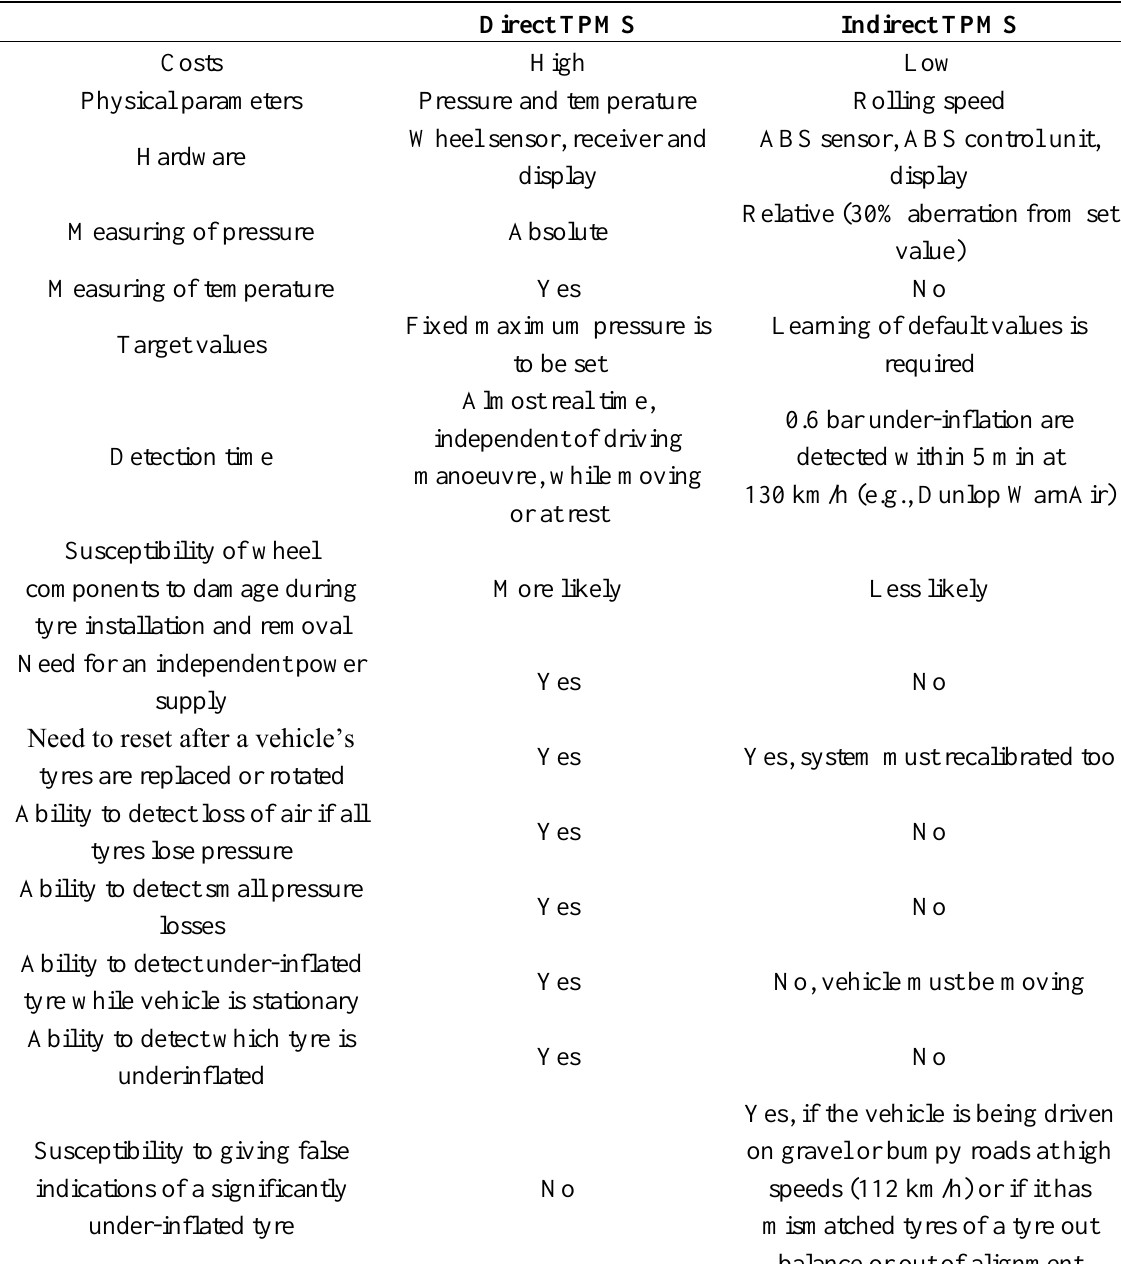
Table 2. Comparison between direct and indirect TPMSs